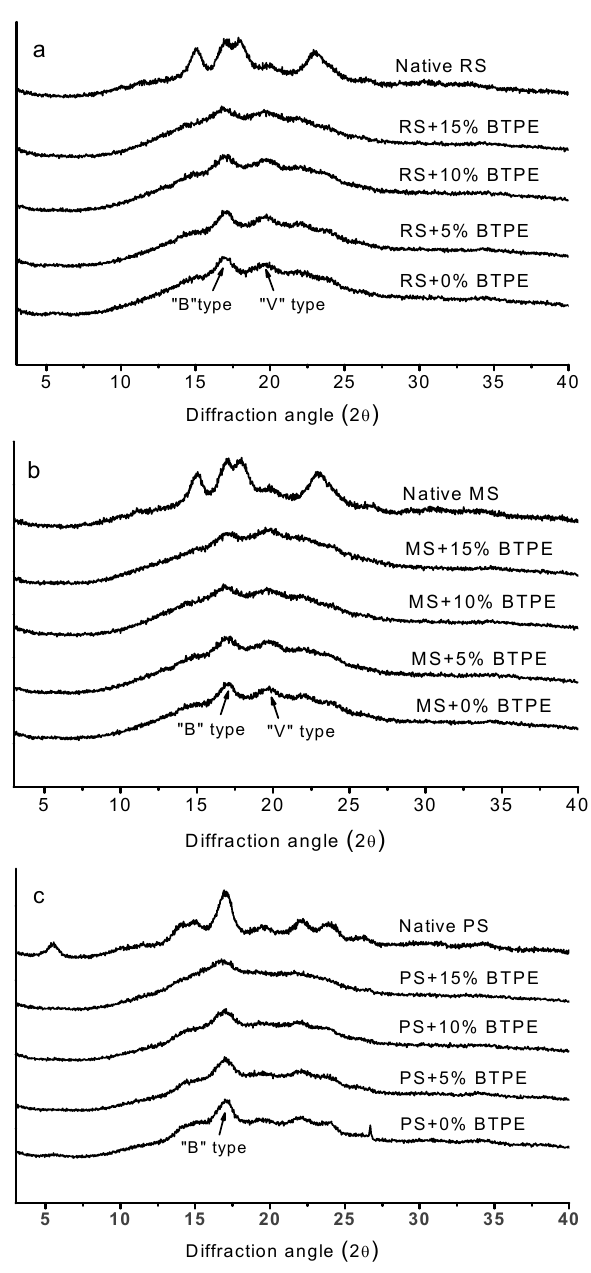
Figure 1. X-ray diffraction of native starch and gelatinized starch gels from different botanical sources containing different concentrations of black tea polyphenol extract (BTPE) after 10 days storage at 4 °C. ( a ) RS, rice starch; ( b ) MS, maize starch; ( c ) PS, potato